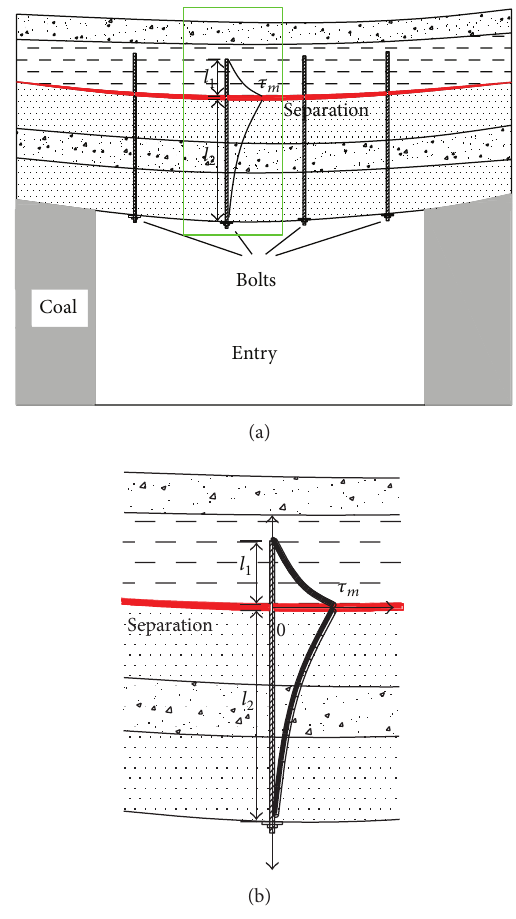
Figure 4: Schematic illustration of the shear stress distribution along bonding interface with separation (without interfacial dam-